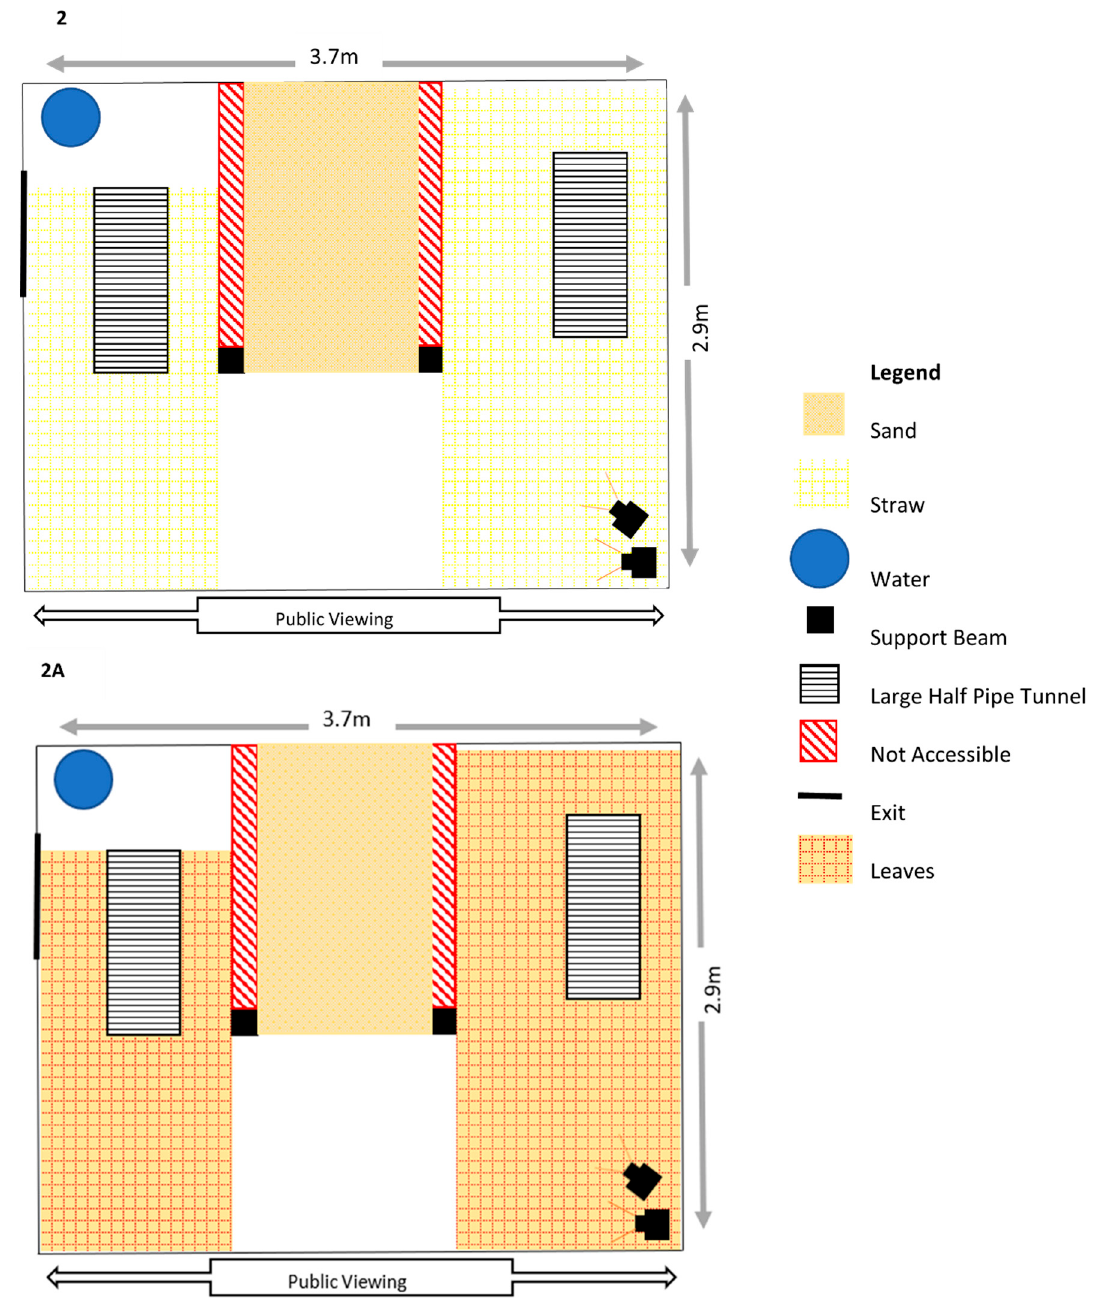
Figure A3. Diagram of Enclosure 2 & 2A. Enclosure 2 top is the unchanged enclosure for the radiated tortoises, enclosure 2A bottom is the environmentally changed enclosure for the radiated tortoises, with camera placement.